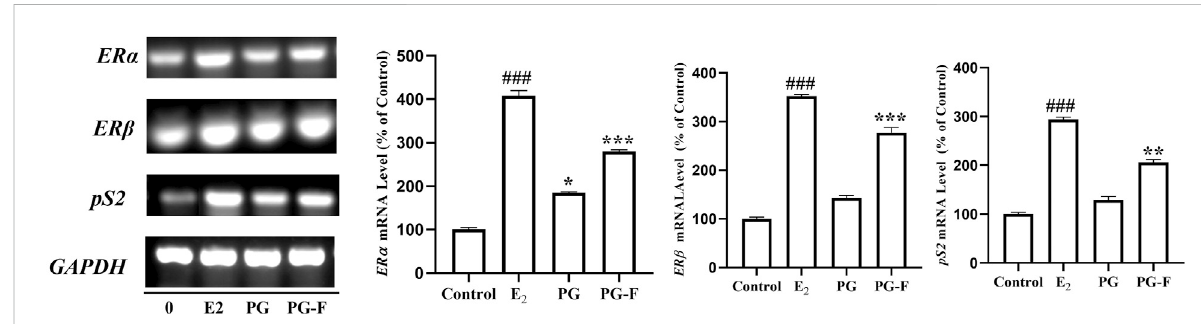
FIGURE 5 EffectofPomegranateonthetranscriptionalactivationoftheER α ,Er β ,andpS2genesinMCF7cells.MCF7cellsweretreatedwithPomegranate juice for 24 h. Subsequently, total RNAs were extracted, and the mRNA expression levels were determined by RT-PCR analysis and compared with thoseofGAPDH.Thedatashownarerepresentativeofthemeanvaluesofthreeindependentexperiments±SD.* p < 0.05,** p < 0.01,*** p < 0.001as compared with the group treated with E2, and ### p < 0.001 as compared to the control.